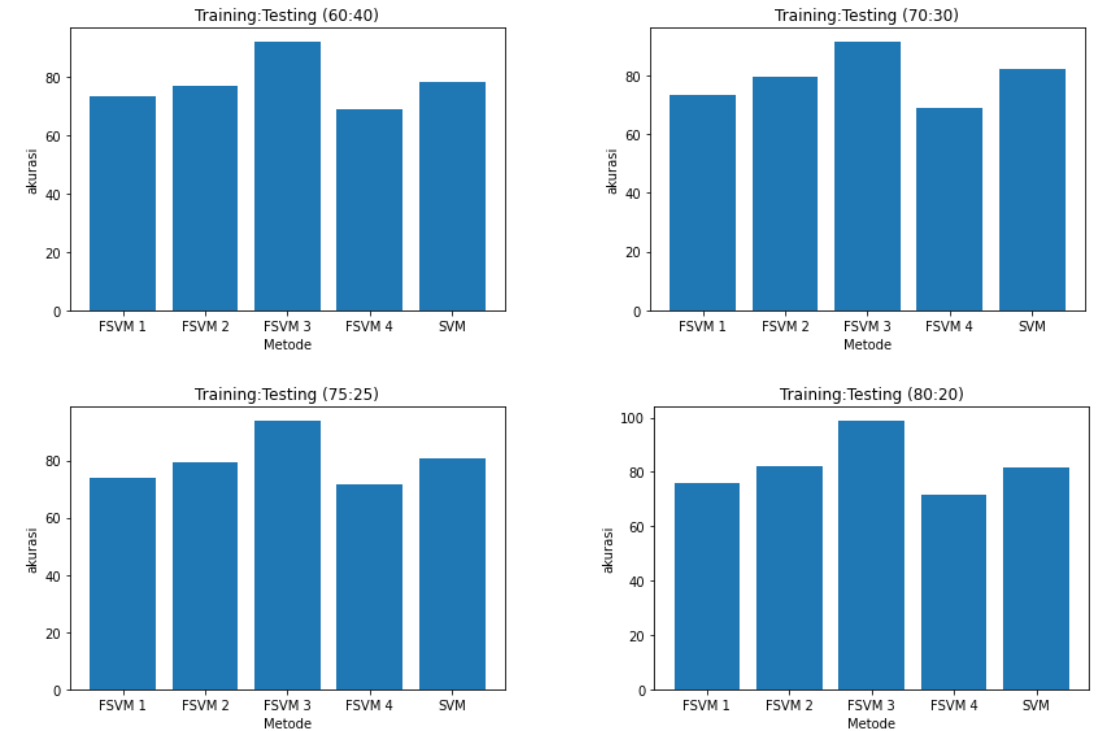
Figure 2. Graph of Model Performance Evaluation with Different Partitions of Training and Testing Data